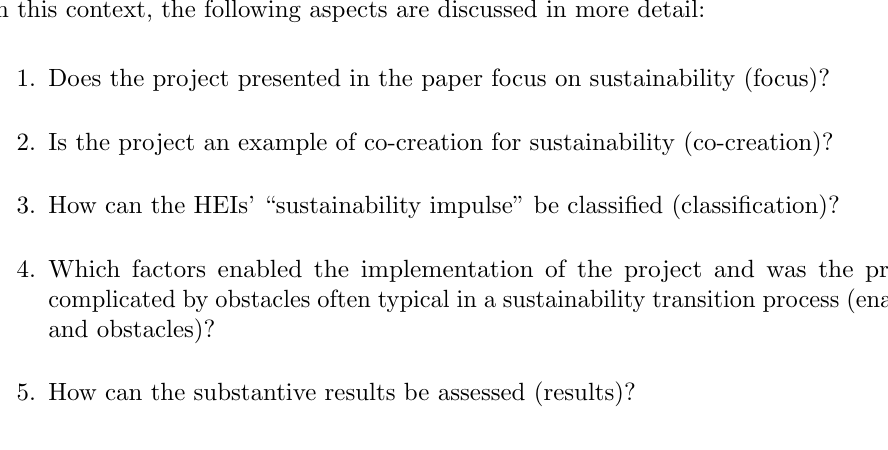
Figure 5: Size, structure and barrier-free accessibility of shops in